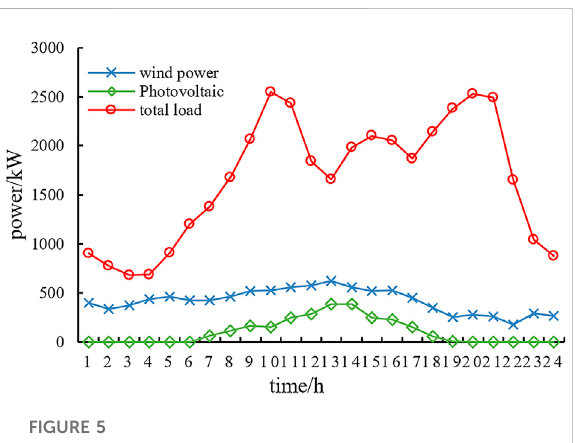
FIGURE 5 Wind and photovoltaic output curves on a typical day. FIGURE 6